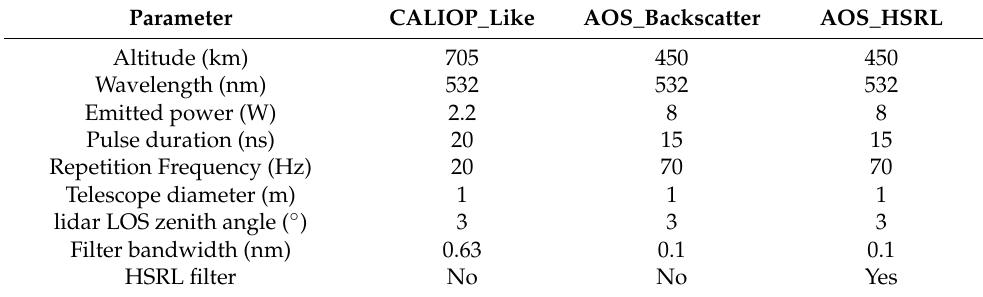
Table 2. Instrumental characteristics of the CALIOP, AOS_Backscatter, and AOS_HSRL